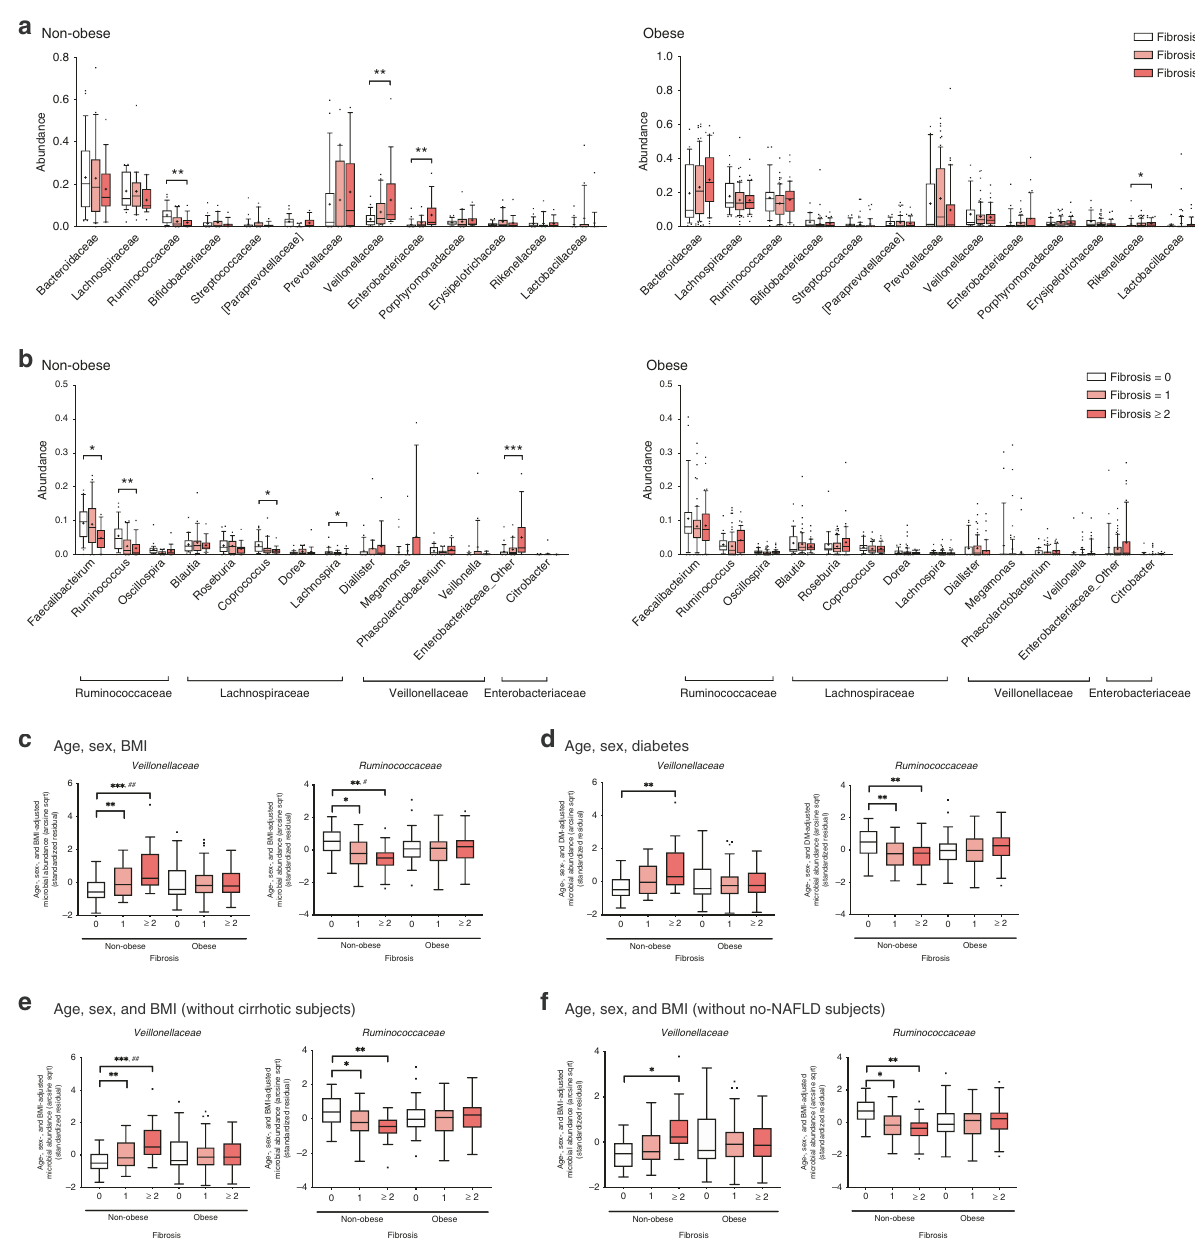
Fig. 2 Phylogenetic comparisons of the gut microbiome in non-obese and obese subjects. a The 13 family- and b 14 genus-level taxa with top abundances are depicted for clarity. Statistical signi fi cance was measured using a nonparametric Kruskal – Wallis test with Dunn ’ s multiple comparison test. The P values are as follows: panel ( a ): ** P = 0.0013, ** P = 0.0054, ** P = 0.0016, and * P = 0.04; panel ( b ): * P = 0.0217, ** P = 0.0013, * P = 0.0209, * P = 0.0234,